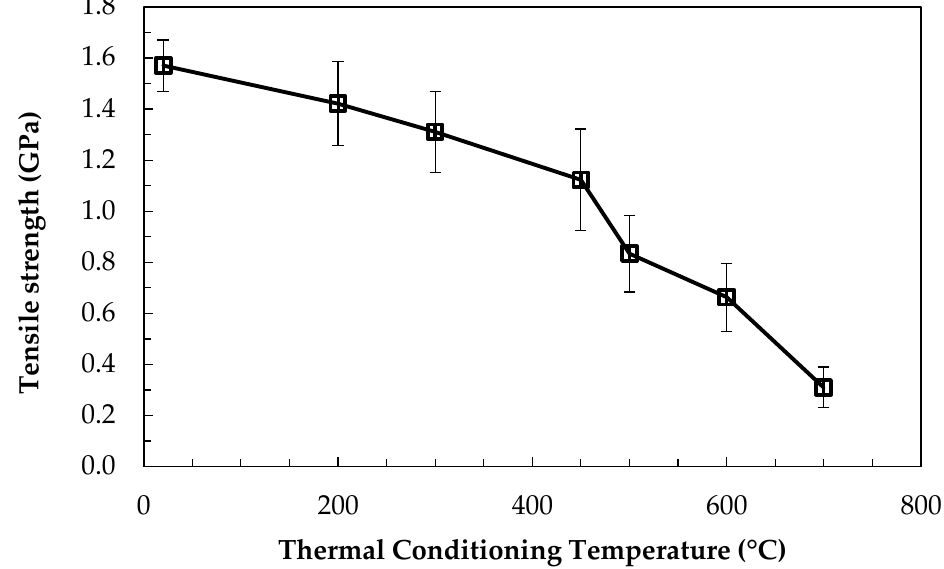
Figure 1. Tensile strengths of bare fibres after thermal conditioning at 200–700 °C for 25 min.